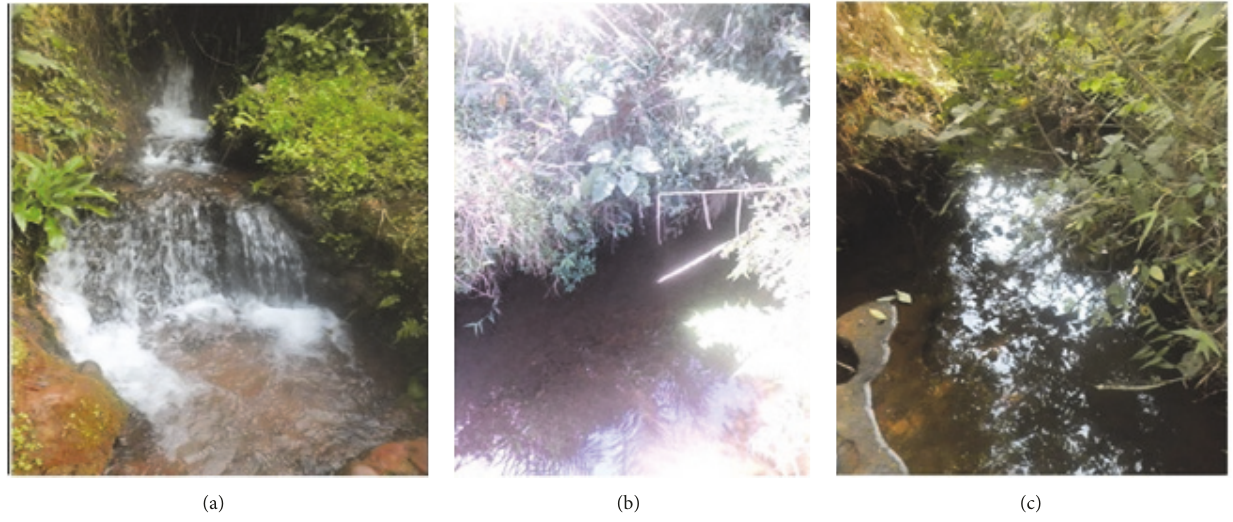
Figure 2: Sampled springs ((a) Achialum; (b) Meupi; (c)